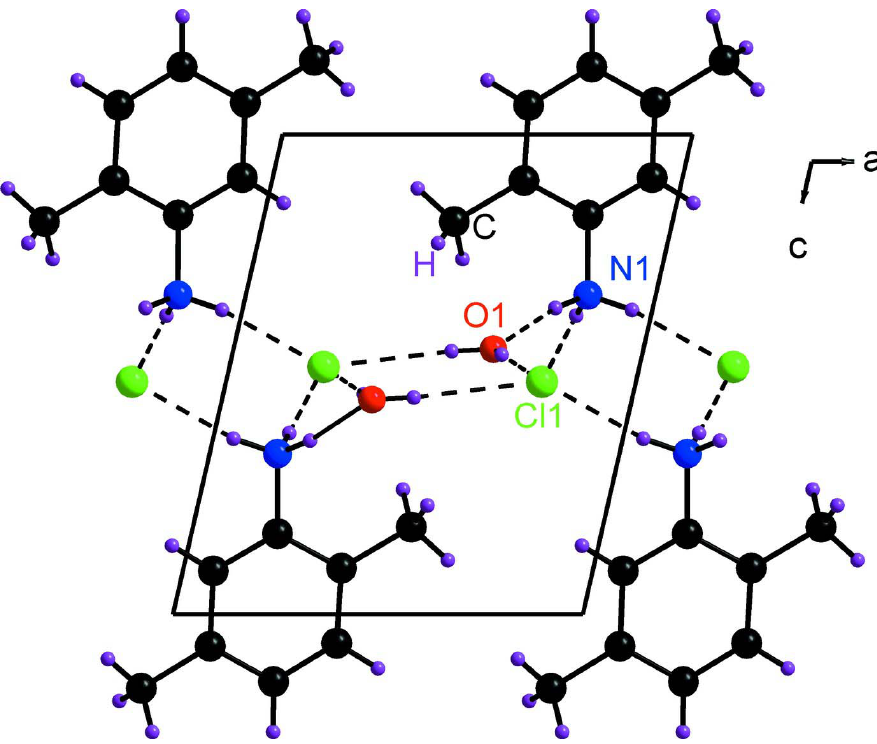
A view of the atomic arrangement of the title compound along the b axis with H bonds shown as dashed